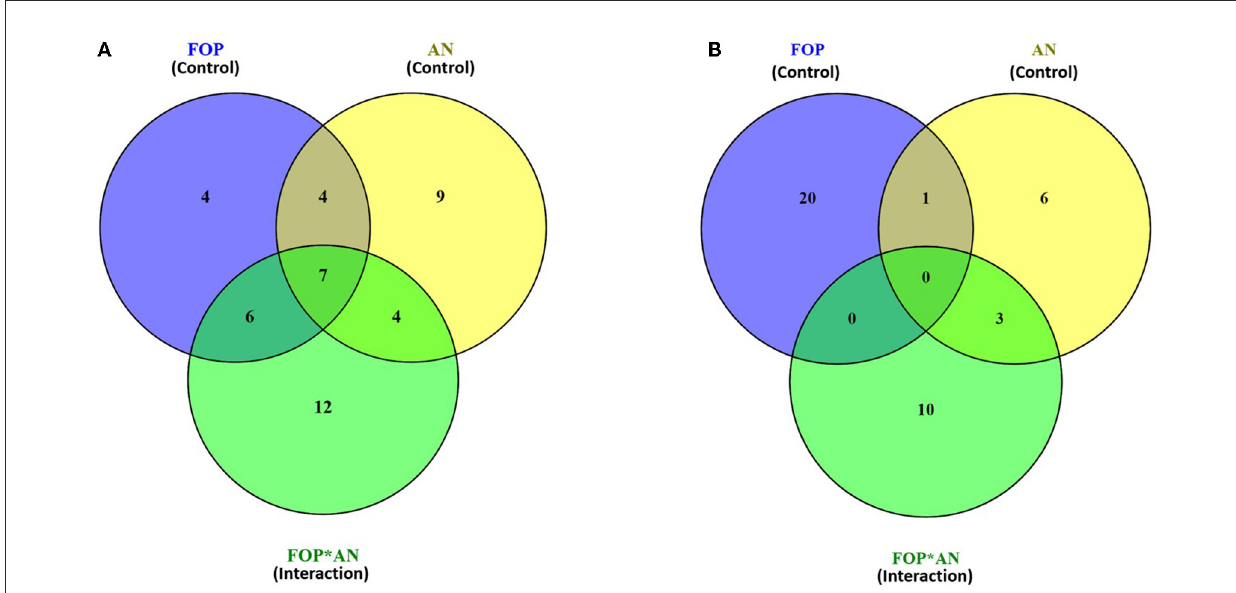
FIGURE8 Venn diagram representing the compounds identified through GC–MS analysis of (A) hexane and (B) ethyl acetate fractions during F. oxysporum f. sp. psidii and A. niger interaction.